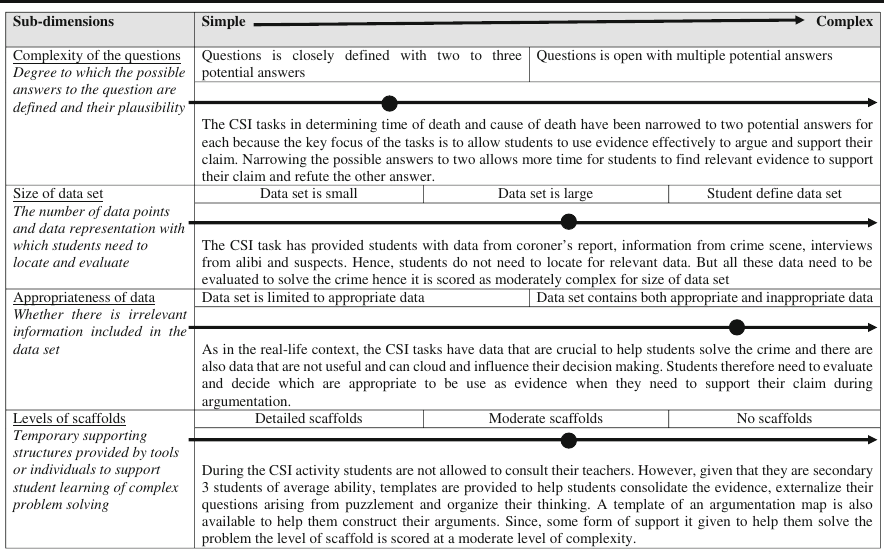
Table 1 Degree of complexity for the four sub-dimensions in the CSI activity for average to high ability secondary three